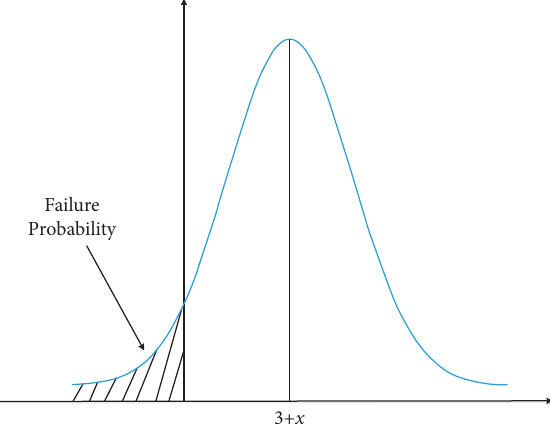
Figure 10: The probability distribution of the difference between O and D